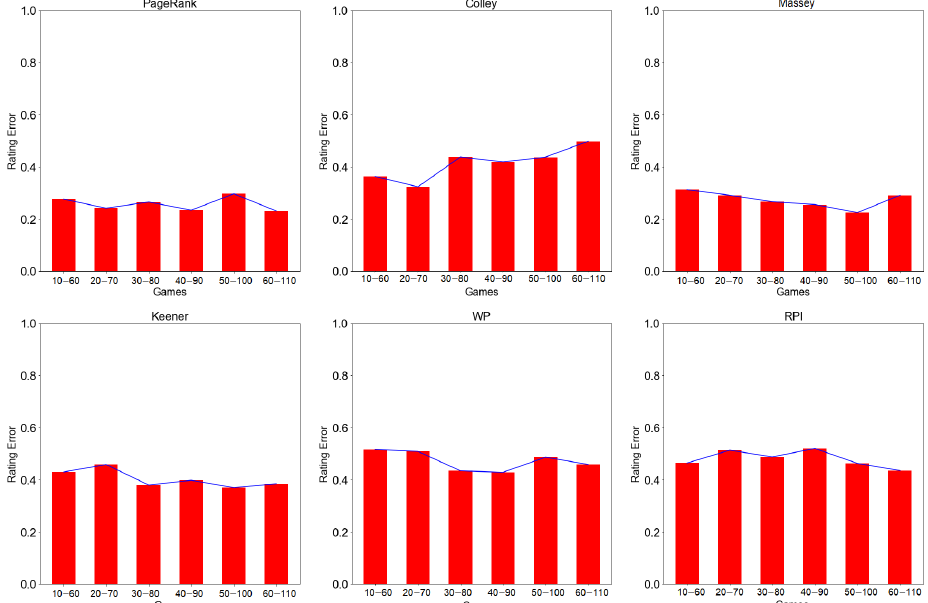
Figure A1. Rating error at different window times for PageRank, Colley, Massey, Keener, WP, and RPI methods by rolling window approach. E φ ( t ) measures the spread of the team rating. A lower E φ ( t ) indicates high prediction power and better rating performance, while larger E φ ( t ) indicates low prediction power and hence low rating performance.